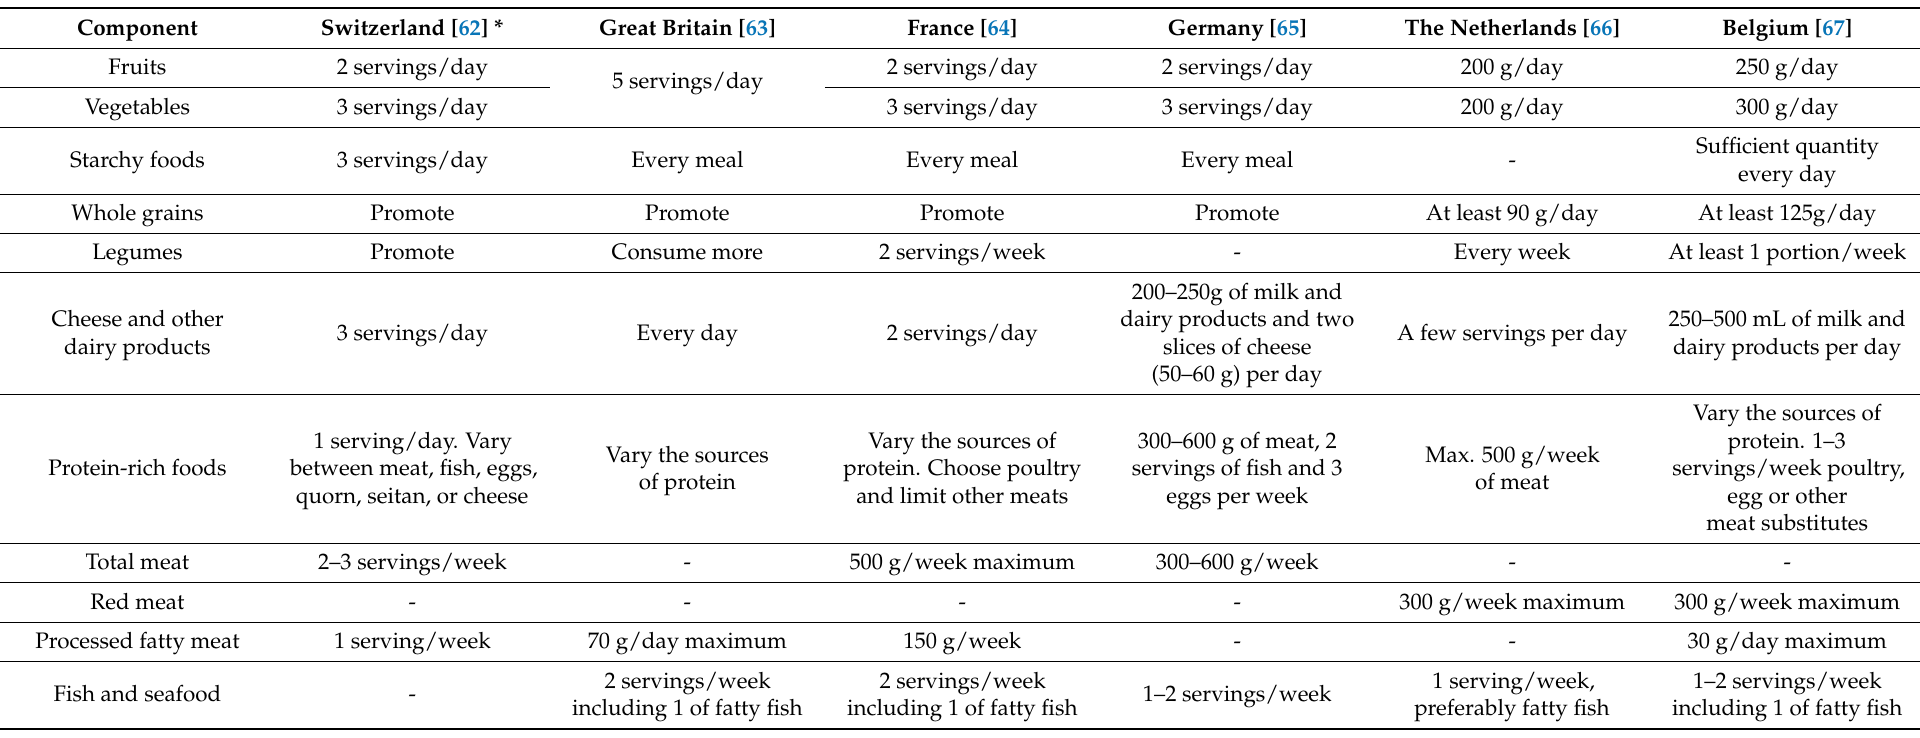
Table A1. Comparison of the dietary guidelines in various countries for the components used in SCASA (Score d’Alimentation